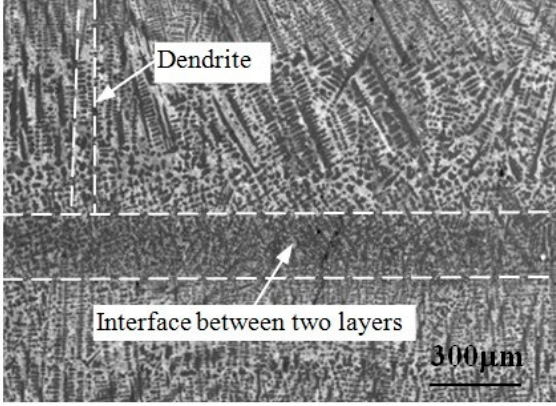
Figure 2. SEM micrograph of Fe314 laser cladding coating [51]. “Reproduced with permission from published by © Springer.” (2015).